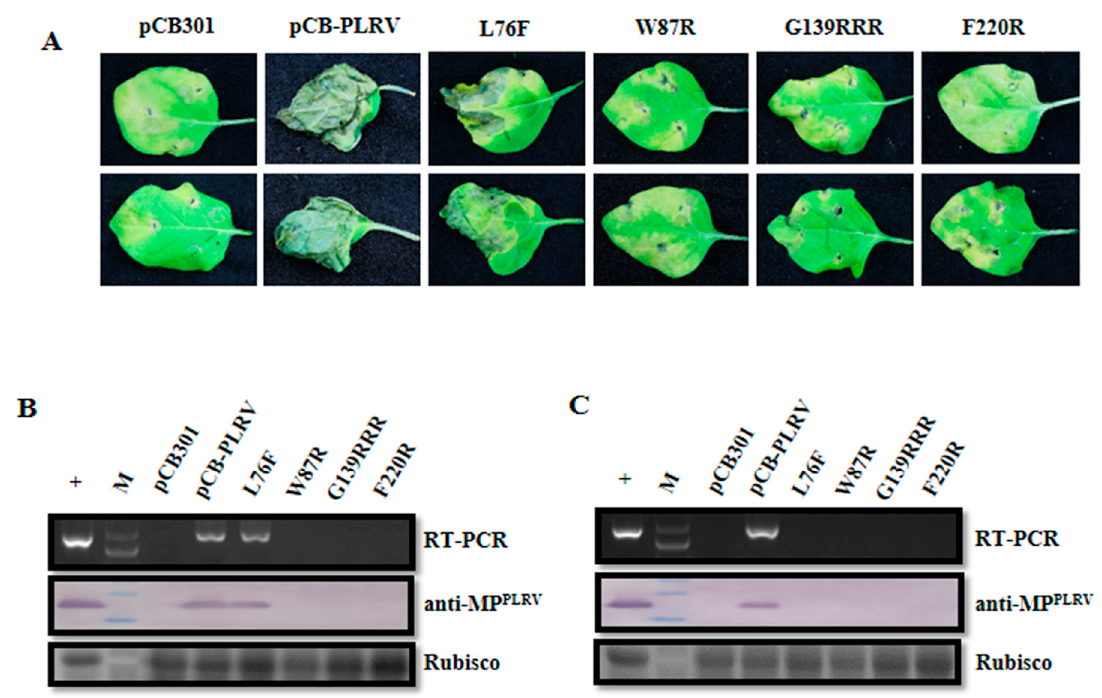
Figure 6. Infectivity analysis of the VSR defective mutants in F-box-like motif, G139/W140/G141-like motif, and C-terminal conserved region derived from the pCB-PLRV in black nightshade plants. ( A ) Symptoms on black nightshade leaves agroinfiltrated with pCB empty vector (negative control), wild-type pCB-PLRV (positive control) and mutants pCB-PL-L76F, pCB-PL-W87R, pCB-PL-G139RRR and pCB-PL-F220R respectively, at 5 dpi. ( B ) Assessment of viral RNA and protein accumulation in potato leaves inoculated with pCB-PLRV mutants by RT-PCR amplification and western blot analysis at 3 dpi. ( C ) Assessment of viral RNA and protein accumulation in systemic leaves of potato plants inoculated with pCB-PLRV mutants by RT-PCR amplification and western blot analysis at 14 dpi. Extracts from inoculated N. benthamiana leaves were used as a positive control. The upper panel shows the RT-PCR amplification with PLRV-specific primer pair. The middle panel shows the western blot analysis with the PLRV-MP specific antibody (anti-MP PLRV ). Rubisco stained with Coomassie brilliant blue used as a loading control is shown in the lower panel.